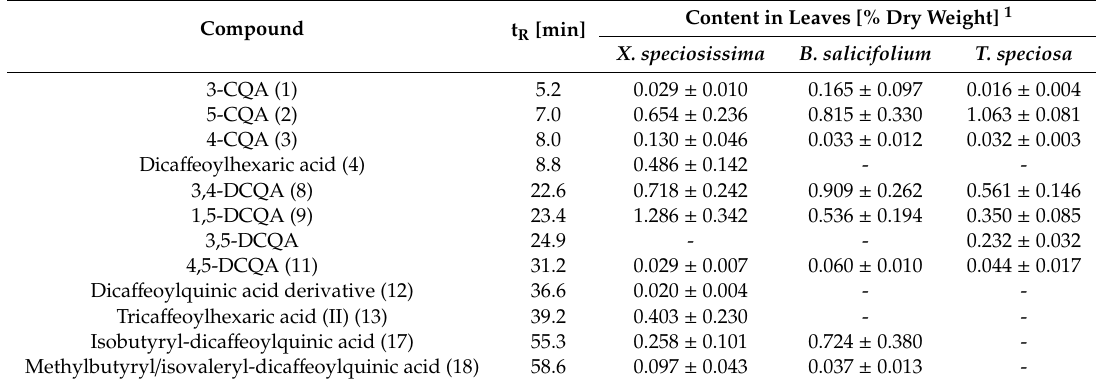
Table 2. Retention times (t R ) and contents of major caffeic acid derivatives in leaves of Xerolekia speciosissima , Buphthalmum salicifolium and Telekia speciosa .